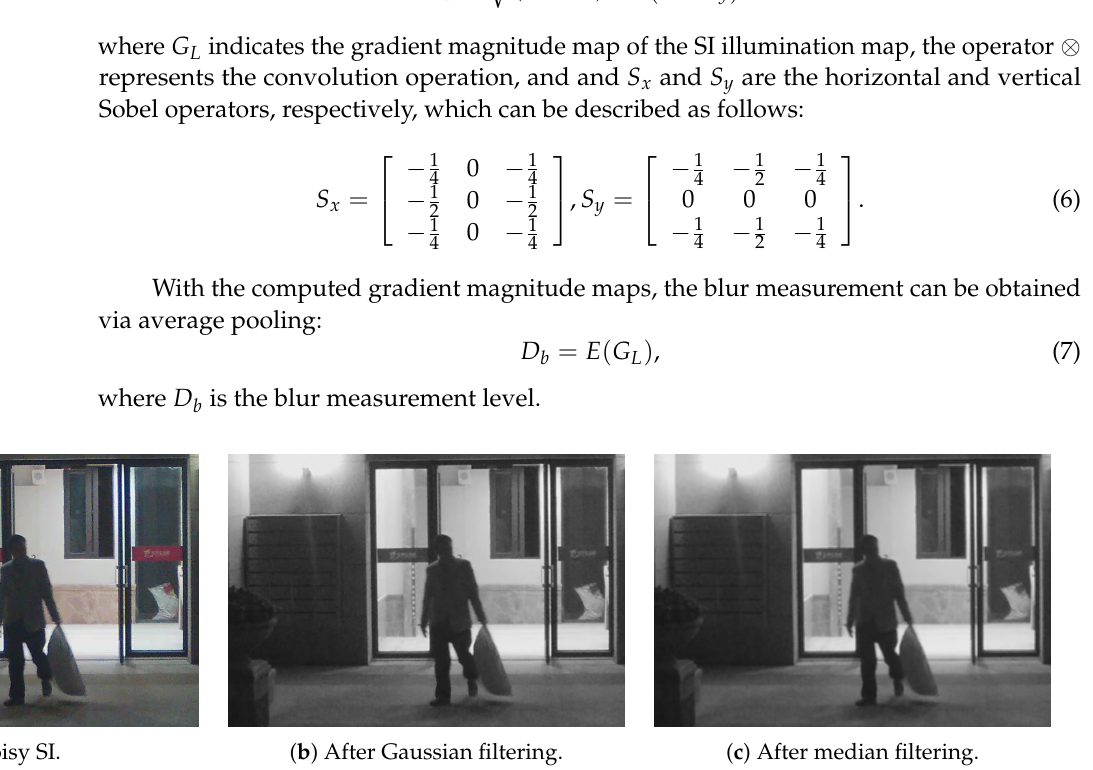
Figure 3. Examples of noisy images and denoised gray images. The noise in the low-light and flat regions is reduced after Gaussian and median filtering.